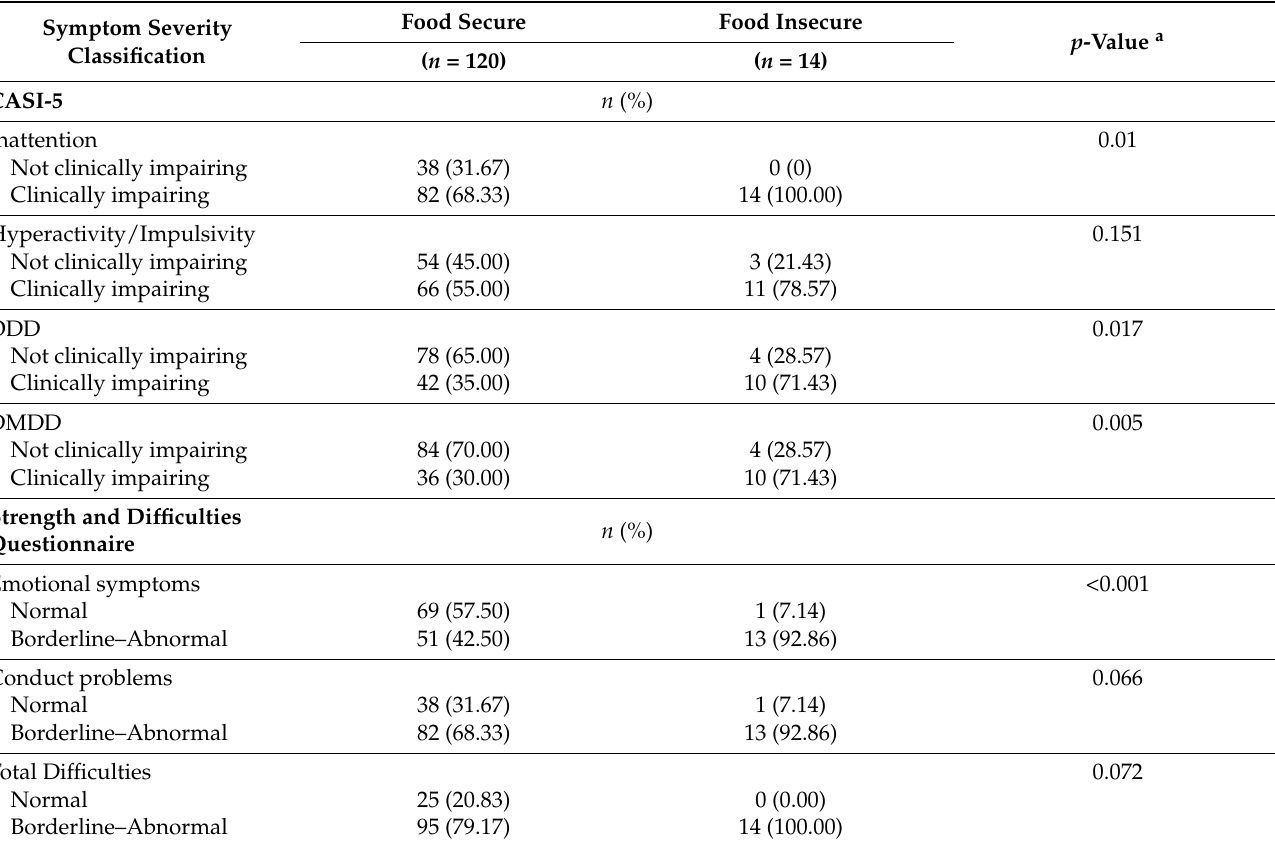
Table 2. The proportion of participants with severe symptoms according to household food secu- rity